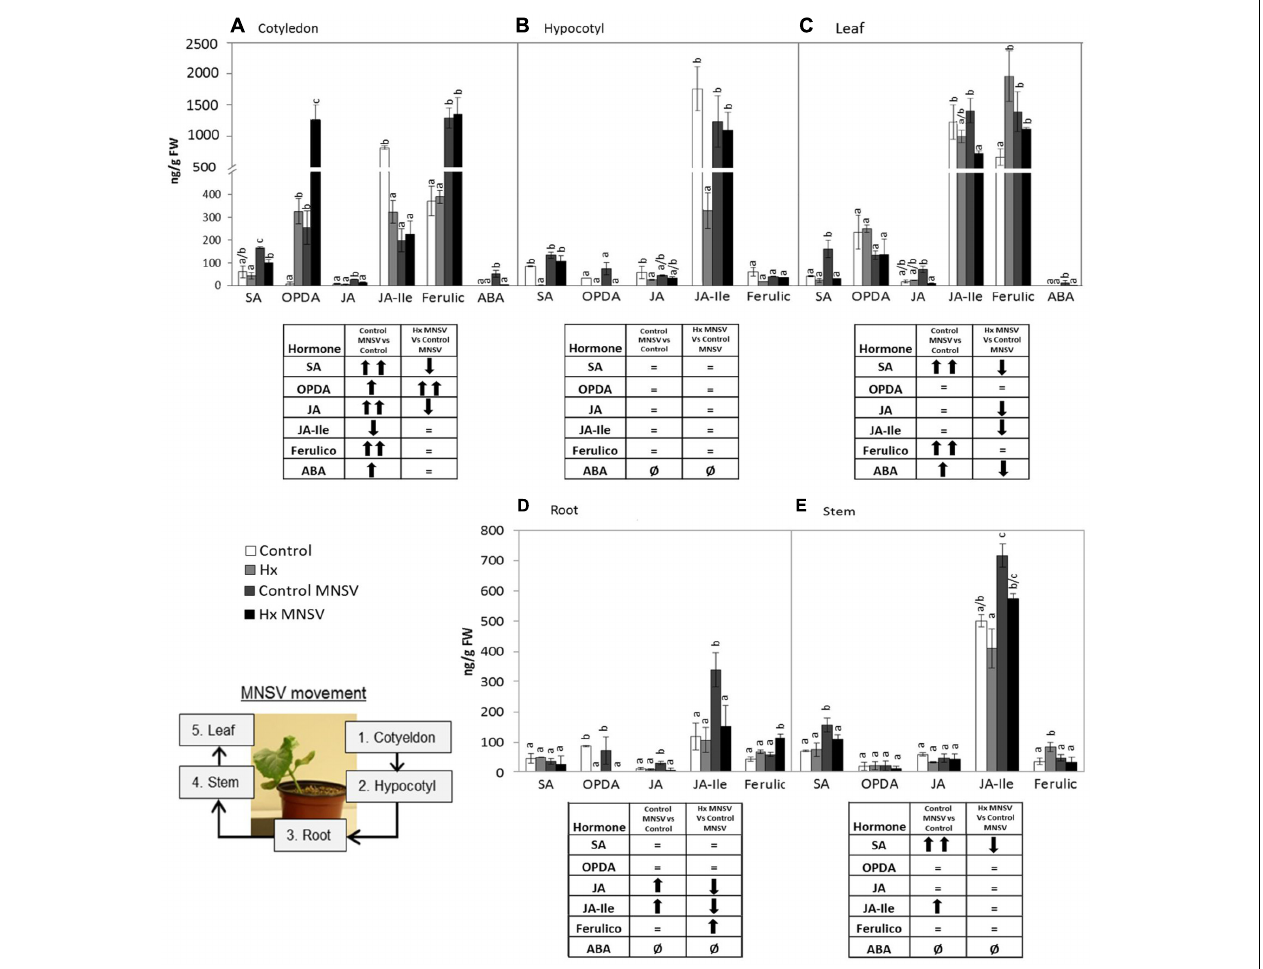
FIGURE 9 | Metabolic profile in the control and Hx-treated plants upon MNSV infection in late infection stages. Plants were grown and inoculated as described in Figure 2C . Different tissues were collected at 12 dpi, and the SA, OPDA, JA, JA-Ile, ferulic acid, and ABA levels were determined by UPLC–MS. (A) Cotyledon, (B) hypocotyl, (C) leaf, (D) root, and (E) stem metabolic contents. Significant changes are symbolized in a table below the graph: (=) no significant differences; ( ↑ , ↓ ) statistically significant increase or decrease; and ( ↑↑ , ↓↓ ) statistically significant twofold increase or decrease. An insert denotes the route of the virus from the inoculation site (cotyledons) to reach systemic tissue (leaves) through the vascular system. Data represent the mean ± SE of three independent experiments with 10 plants per experiment. Letters indicate statistically significant differences for each hormone ( p < 0.05; least significant difference